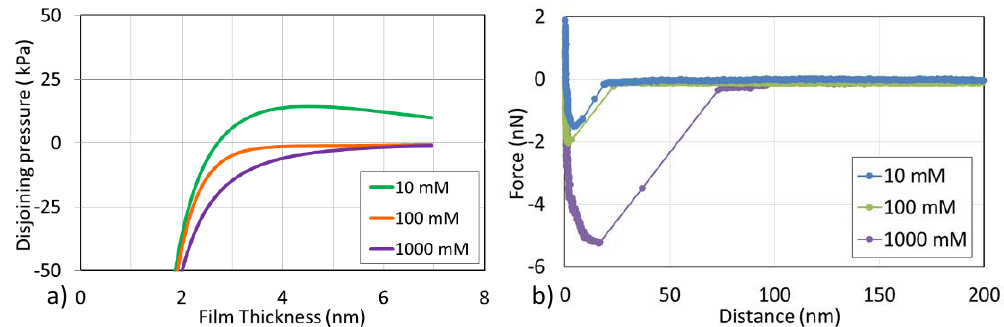
Figure 2. ( a ) Disjoining pressures and ( b ) Adhesion forces of asphaltene-brine-silica systems in the presence of various salinities.